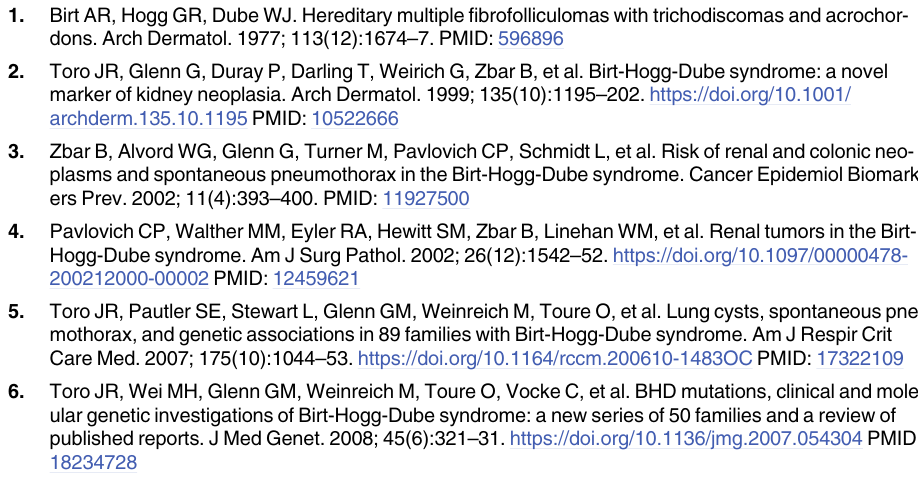
S1 Table. Swedish cohort of BHDS. Test result, variant and clinical phenotype is included for each individual. Each number represents one family and each letter represents one individual, ex 2a, 2b and 2c are three individuals which belong to the same family. N/A: Not available, CRC: Colorectal cancer, MDS: Myelodysplastic syndrome. S2 Table. Family history of our cohort. Pathogenic FLCN variant and clinical phenotype for each individual included in the study. FH: Family history, CRC: Colorectal cancer.